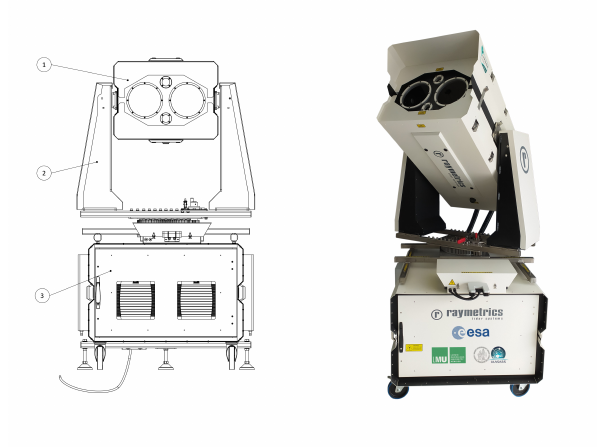
Figure 1. The lidar head (1), the alt-azimuth positioner (2), and the electronic enclosure (3) of the eVe lidar